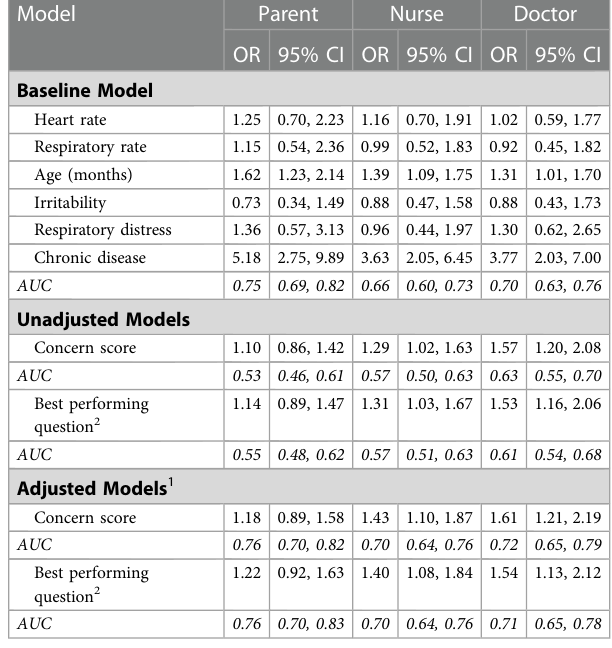
TABLE 2 Odds ratios (ORs), 95% con fi dence intervals (CIs) and area under the receiver operator characteristic curve (AUC) to predict the primary outcome of sepsis at time of survey completion, with parents, nurses, and doctors concern as independent predictors. The columns each display the results for the children in relation to parent surveys, nurse surveys and doctor surveys, respectively. The baseline model is a multivariable model based on easily available observations at presentation. The concern score was derived from the exploratory factor analysis of responses to fi ve questions assessing concern. The AUC and 95% con fi dence intervals (CI) of the AUC for each model are shown in